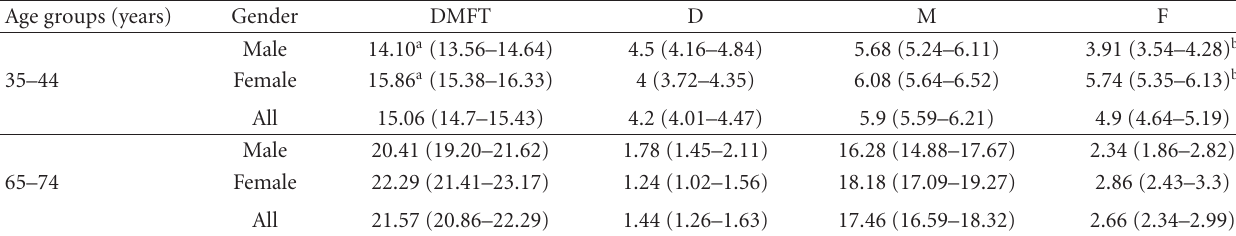
Table 2: DMFT index and its components (mean and 95% confidence